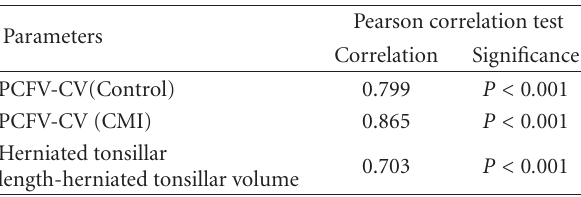
Table 5: Correlation values among the three parameters. Pearson correlation test Parameters Correlation Significance PCFV-CV(Control) 0.799 PCFV-CV (CMI) 0.865 P < 0 . 001 Herniated tonsillar length-herniated tonsillar volume